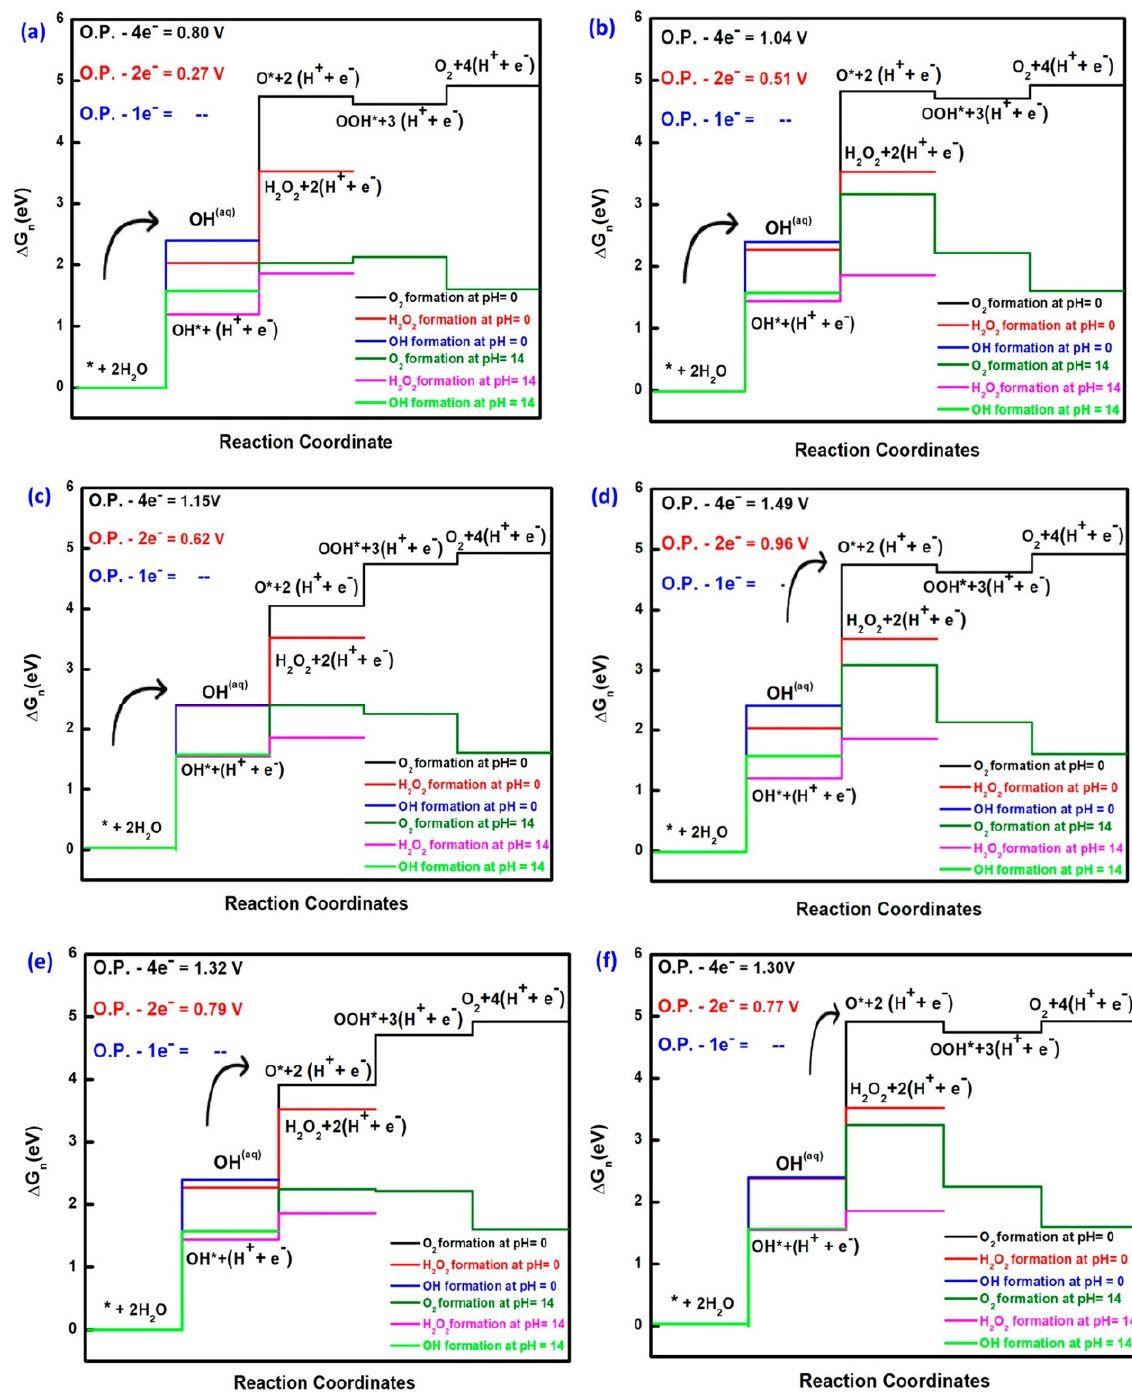
Figure 9. OER free energy diagrams involving peroxo O2* species on ( a ) TiO 2 rutile (110), ( b ) anatase (101), and ( c ) brookite (210) and through dangling O1* species on ( d ) TiO 2 rutile (110), ( e ) anatase (101), and ( f ) brookite (210) without any external potential. (Red line = generation of H 2 O 2 at pH = 0; Black line = evolution of O 2 at pH = 0; blue line = generation of OH t pH = 0; pink line = generation of H 2 O 2 at pH = 14; dark green profile = O 2 formation at pH = 14; light green line = generation of OH at pH = 14.) In all pathways the presence of peroxo O* intermediate can be seen. The arrow represents the rate-determining steps. In the left upper corner the values corresponding to 1e − , 2e − , and 4e − processes at pH = 0 are shown. (Reprinted from ref. [58] with permission from the American Chemical Society. Copyright © 2020, American Chemical Society).